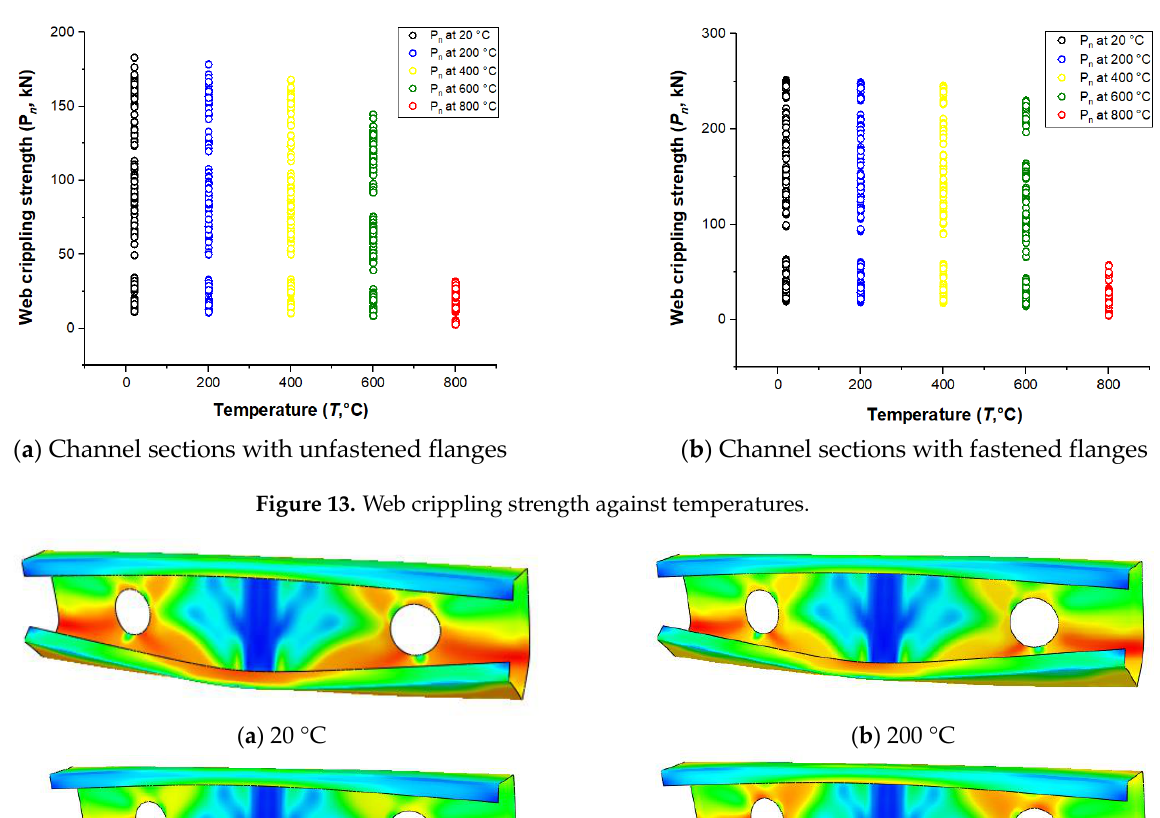
Figure 12. Comparison of web crippling strength of unfastened and fastened flanges.